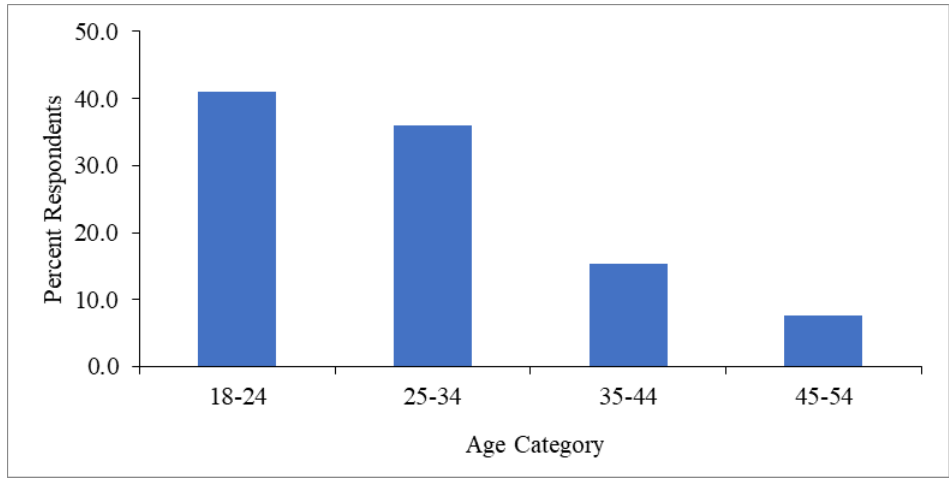
Figure 1. The proportion of the respondents in different age categories.